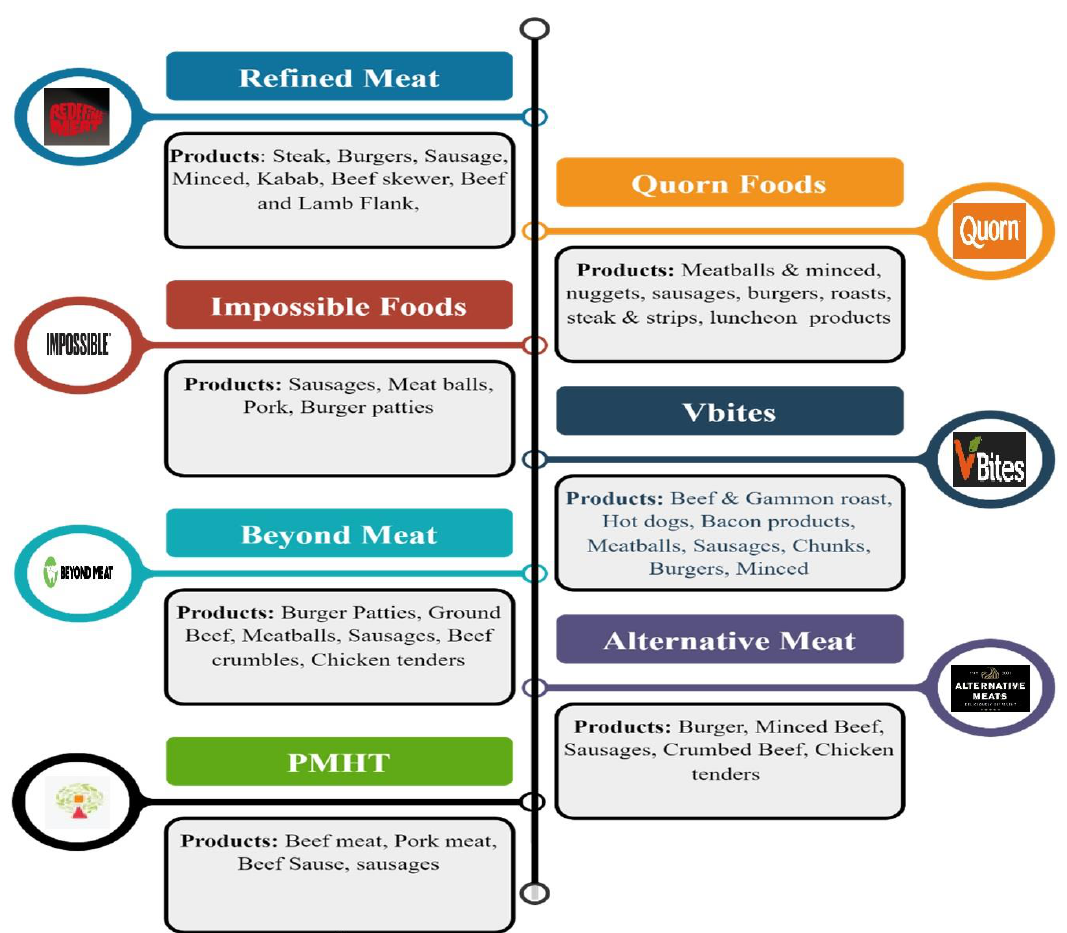
Figure 1. Main products of some plant-based companies of different countries. Table 1. An overview of the previous findings (2020–2022) about plant-based meat effectiveness and